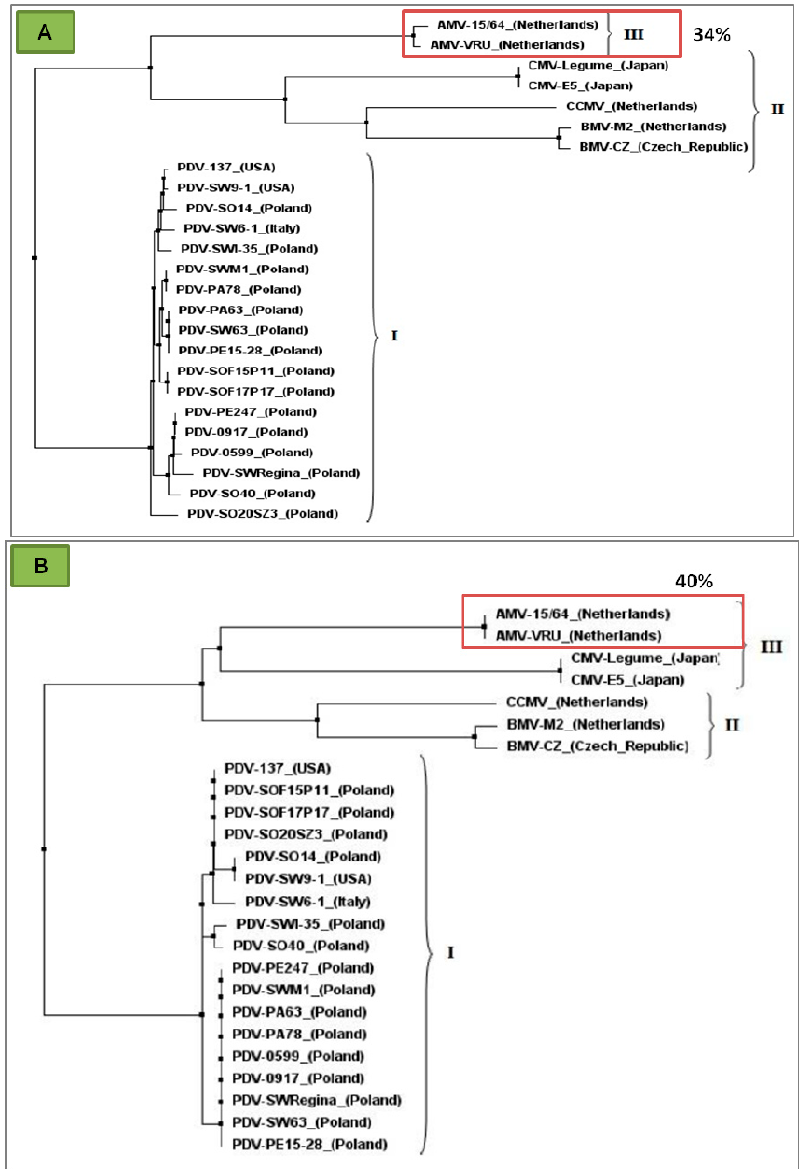
Figure 4. Phylogenetic comparison of amino acid sequences of the MP and RNA binding domain of PDV with several members of Bromoviridae family: ( A ) MP sequences for the studied groups of virus isolates. The highest similarity (maximum likelihood) between PDV and AMV marked in red frame (34%) (modified [36]); ( B ) RNA binding domain of the MPs. The highest similarity (maximum likelihood) between PDV and AMV marked within the red frame (about level 40%), Kozieł et al. [36] modified. On ( A )and ( B ): I- group of analyzed PDV isolates sequences of movement protein, II- group of analyzed Brome mosaic virus (BMV) and Cucumber mosaic virus (CMV) isolates sequences of movement protein, III- group of analyzed AMV and Cowpea chlorotic mottle virus (CCMV) isolates sequences of movement protein.